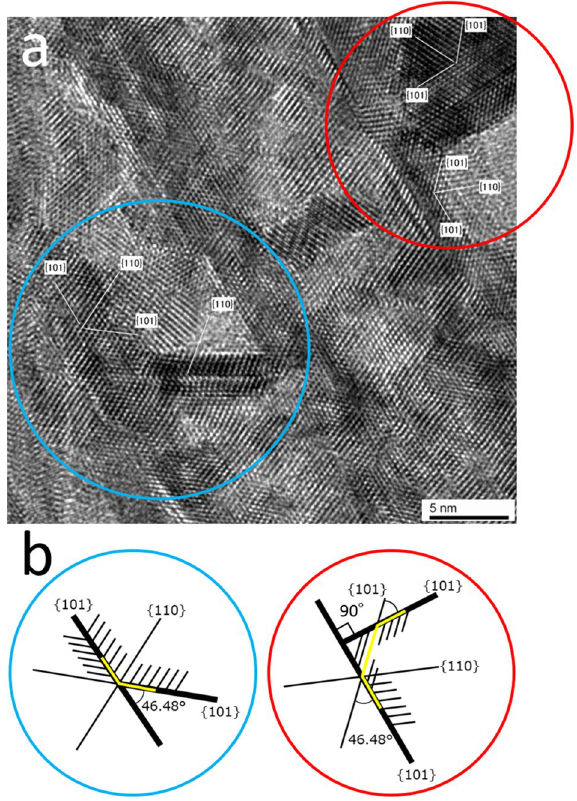
Figure 6. ( a ) High-resolution plane-observed TEM image of the SnO 2 nanosheets that connected with a branch angle of 90° (square A and B) or 46.48° with notations of the crystal planes. ( b ) Crystal growth models of the SnO 2 nanosheets that connected with a branch angle of 90° (right, red circle) or 46.48° (left, blue circle). The models were observed from the direction of B = < 1 − 1 − 1 > of SnO 2